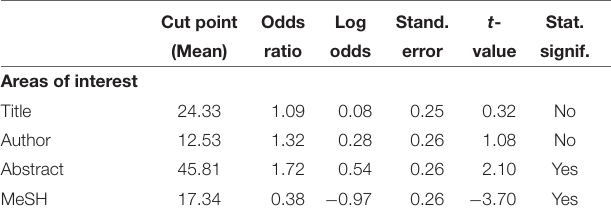
TABLE 7 | Summary of the relationship between number of documents saved and gaze (N number of documents saved = 256, N eye gaze = 256; statistical significance at 95%).